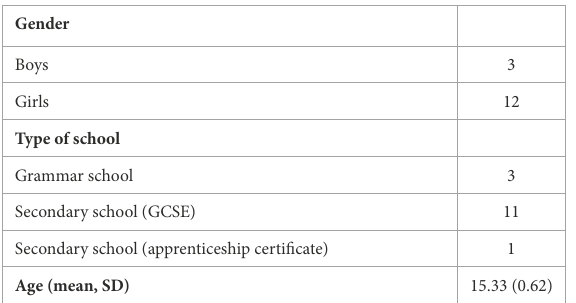
TABLE 1 Descriptive characteristics of the